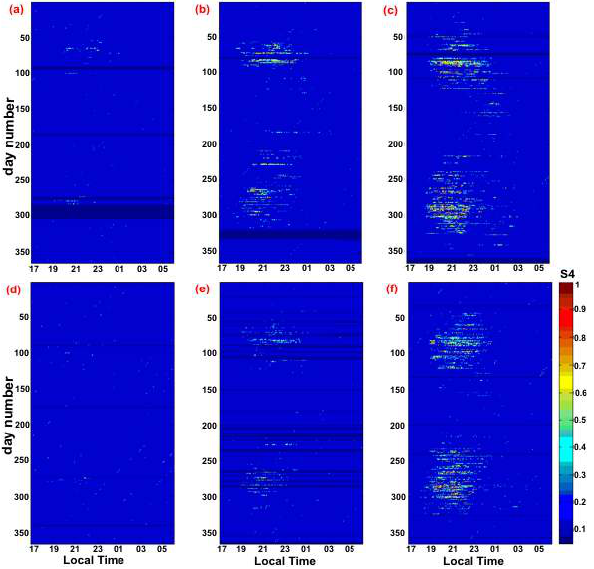
Fig. 5. Seasonal and local time variation of scintillation occurrences at Bandung in (a) 2009, (b) 2010, and (c) 2011 and at Pontianak in (d) 2009, (e) 2010, and (f) 2011. The dark region indicates that no data were observed.